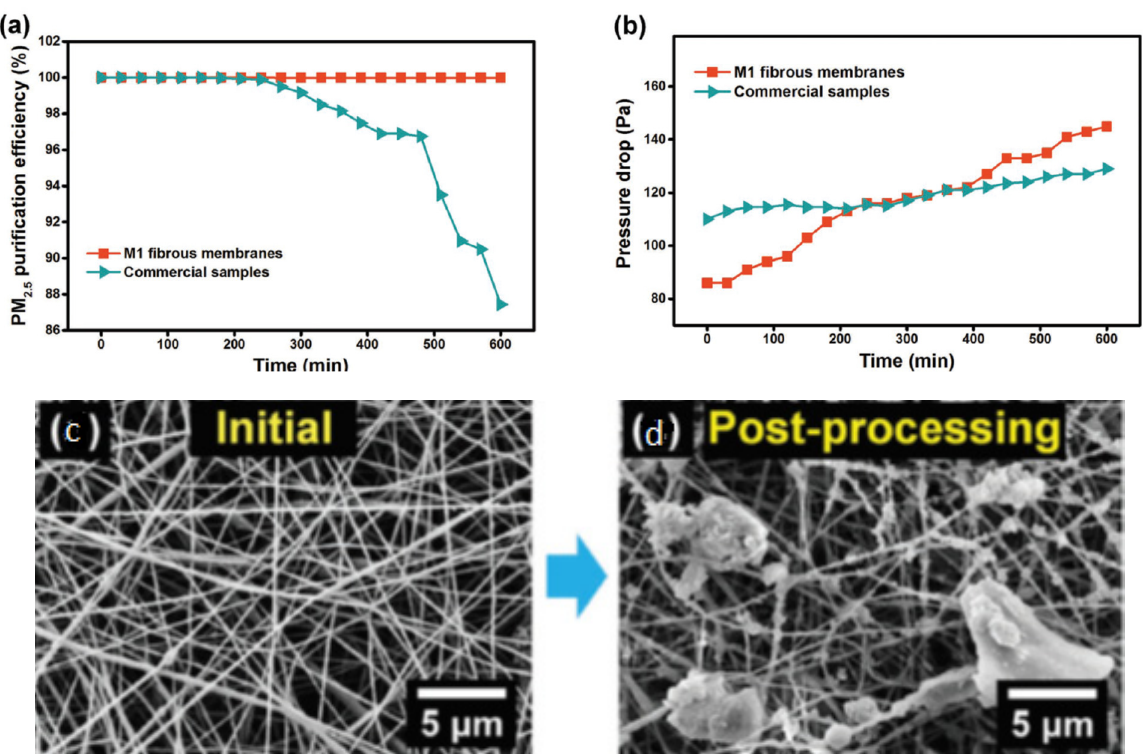
Figure 11. Filtering performance ( a , b ) and SEM micrographs of the multi-layered PVDF/PAN-SiO 2 air filter ( c , d ); ( a ) comparison between the filtering efficiency of the electrospun multi-layered air-filter and the commercial one ( b ) comparison between the pressure drop of the electrospun multi-layered air-filter and the commercial one ( c ) initial fibrous air-filter, ( d ) after treatment (filter testing) with PM2.5 particles. (Reprinted with permission from [60]. Copyright 2017 John Wiley & Sons.).